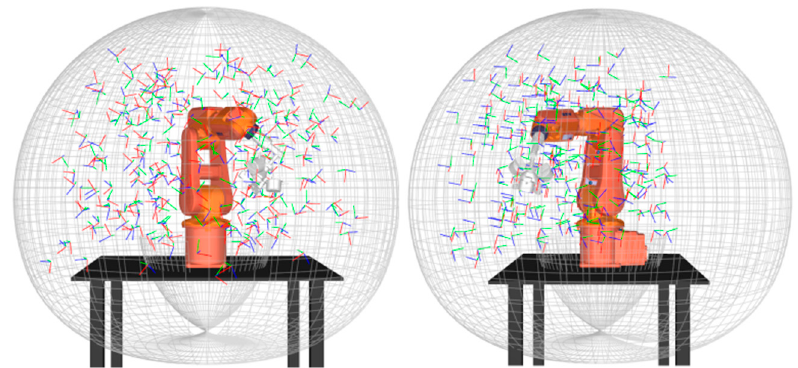
Figure 7. Robot tool poses measured with experimental setup 2.